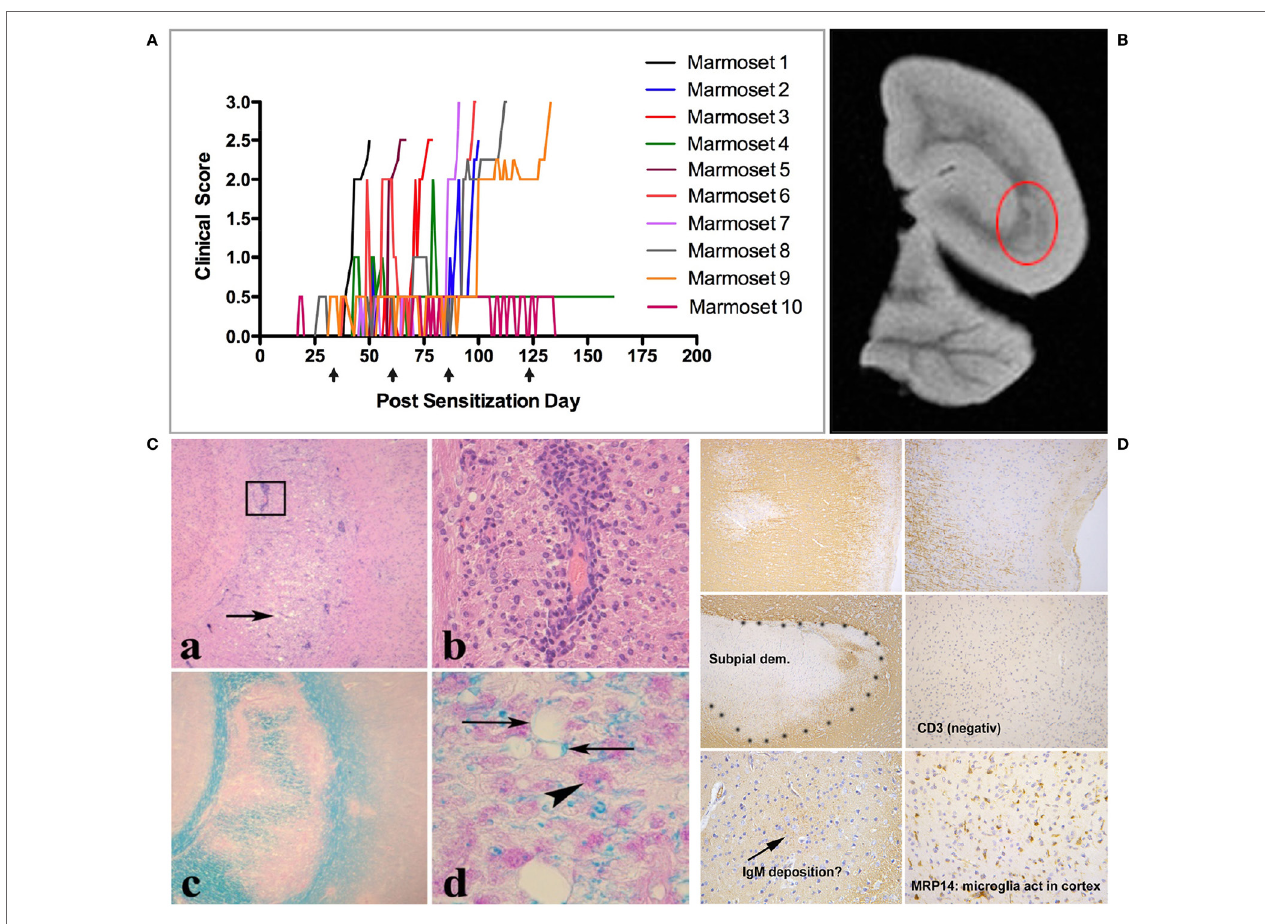
FiGURe 5 | Clinical and pathological aspects of an atypical marmoset experimental autoimmune encephalomyelitis model induced with MOG34–56/ incomplete Freund’s adjuvant (IFA). (A) 10 unrelated marmosets were immunized at 28 days interval (arrows) with MOG34–56/IFA. Depicted is the heterogeneous disease development, comprising early and late responders. (B) A representative T2W magnetic resonance images scan of a formalin- fixed brain half, showing multiple hyperintense regions in the white matter. The encircled lesion (red) was examined for presence of inflammation [ (C) : a,b] and demyelination [ (C) : c,d]. (D) Demyelinated lesions in the cortical gray matter. In these lesions, mononuclear cell infiltrates and antibody deposition are absent, while prominent activation of microglia is